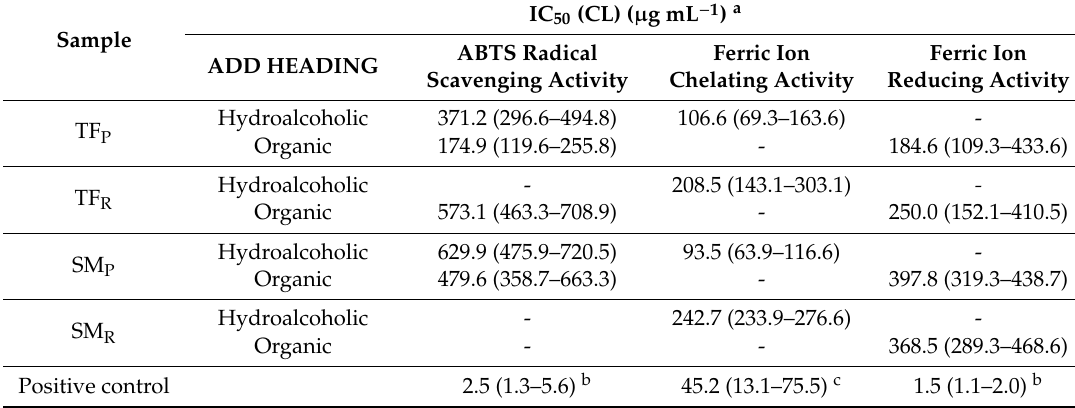
Table 8. E ff ects of hydroalcoholic and organic extracts from both pink ( p ) and red (R) fruits of Solanum lycopersicum var. TF and SM, and standard antioxidant agents in the antioxidant assays a